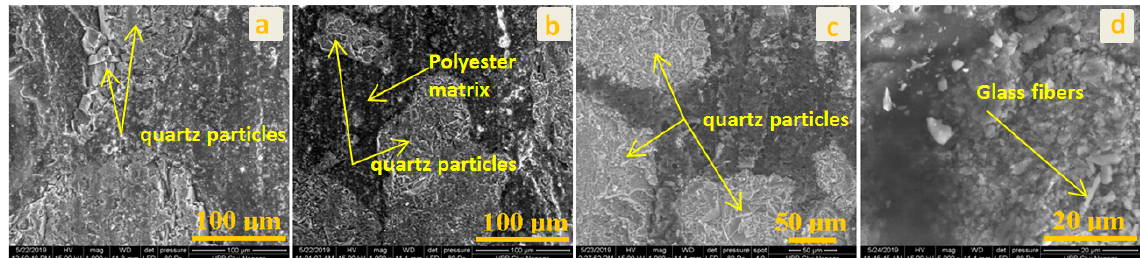
Figure 5. SEM images for structural material: ( a ) control group; ( b ) exposed to rainwater; ( c ) exposed to acetic acid; ( d ) exposed to sulfuric and nitric acid.